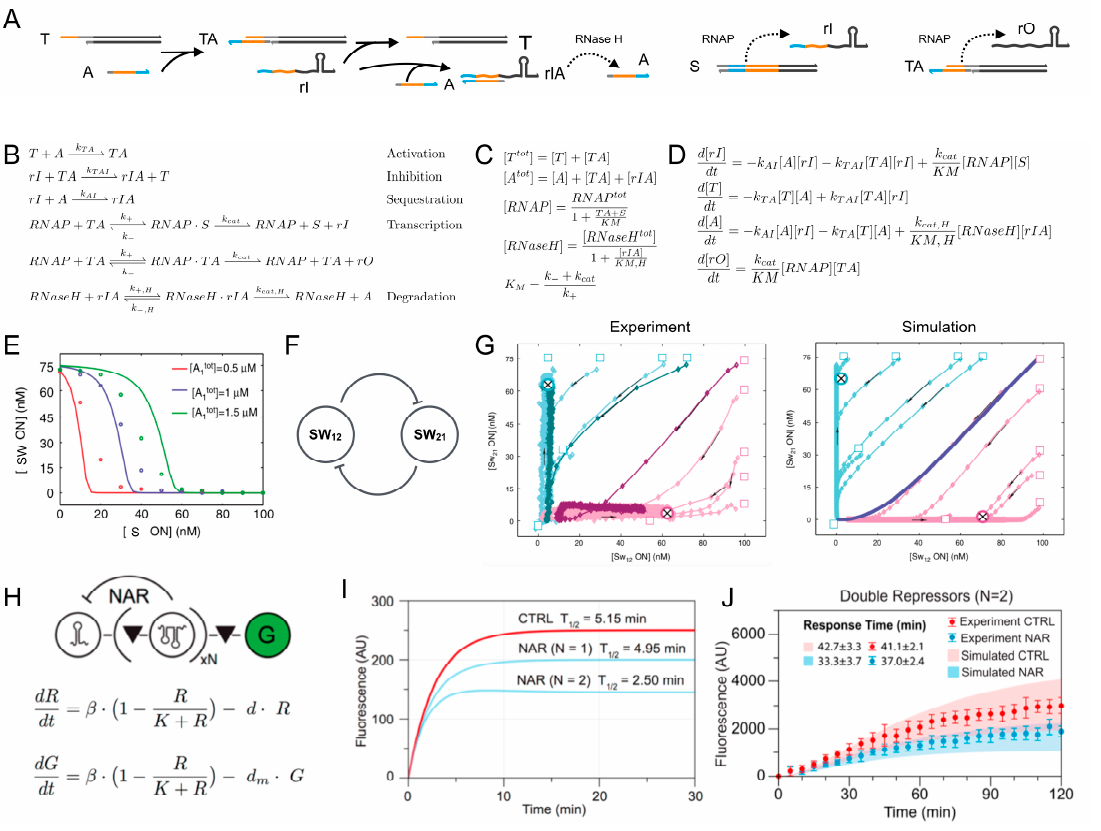
Figure 11. Ordinary differential equation (ODE) models for design and characterization of in vitro synthetic systems. ( A ) Schematic of an inhibited transcriptional switch. ( B ) List of reactions describing a transcriptional switch that is inhibited by RNA transcribed by a source template S. ( C ) Mass conservation and Michaelis–Menten expressions allow a simplification of the ODEs. ( D ) ODEs describing the inhibited transcriptional switch. ( E ) Example data showing the input–output steady state curve mapping the concentration of inhibitor source to the output switch concentration, overlapped with simulated steady state data (solid lines). Reproduced with permission from [39]. ( F ) A bistable switch can be constructed by interconnecting two inhibitor switches. ( G ) Experimental data (left) compared to simulated trajectories (right) of the bistable switch. Reproduced with permission from [39]. ( H ) Example transcription regulator used to build a gene performing NAR. G indicates GFP and its qualitative ODE model. ( I ) The qualitative ODE model suggests that the NAR circuit operates better when using at least two transcription repressors in tandem. ( J ) Simulations of detailed mechanistic models reproduce experimental data well. Adapted with permission from [32].